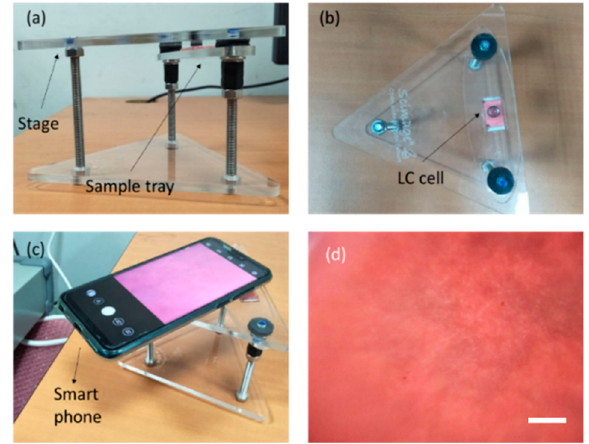
Figure 4. ( a – c ) Smart-phone accompanying designed development for a DDLC sensor chip. ( d ) DDLC macromolecules from the smart-phone’s camera. The scale bar is 300 µm.